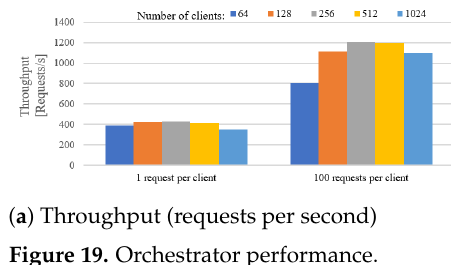
Figure 19. Orchestrator